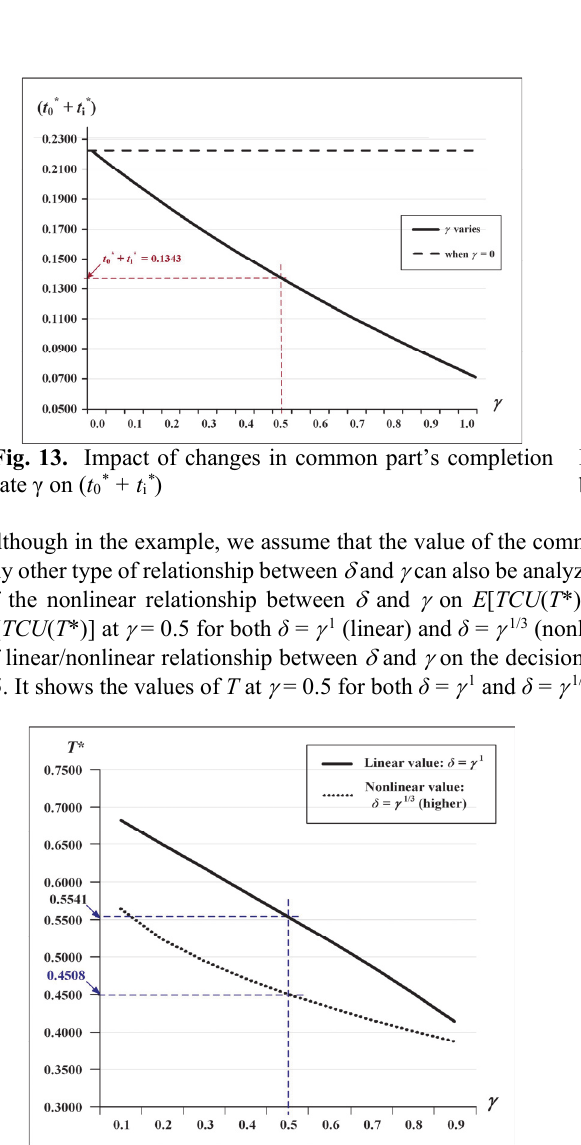
Fig. 15. Influence of linear/nonlinear relationship between  and  on T *